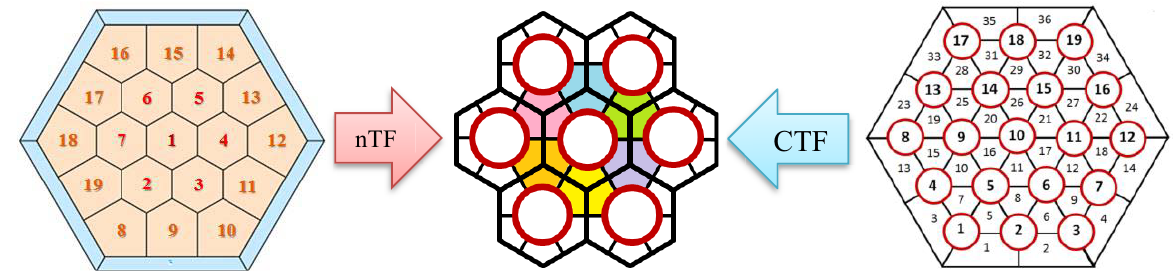
Figure 2. Domain Decomposition in nTF and CTF and superimposition of the